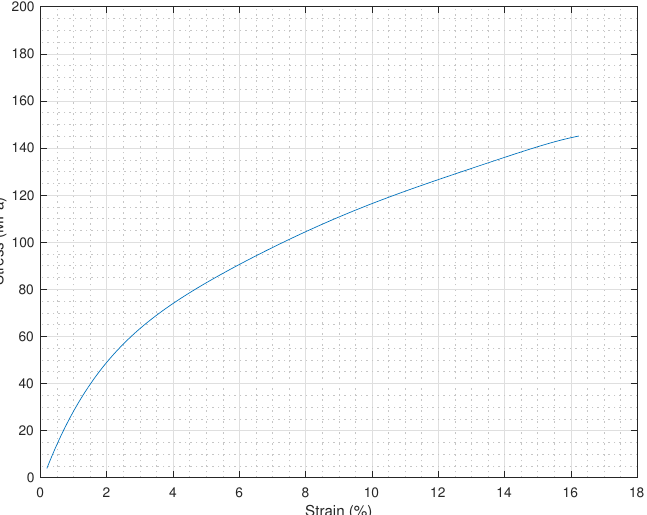
Figure 4. Stress–strain relationship of the composite flag obtained by Dynamic Mechanical Analysis